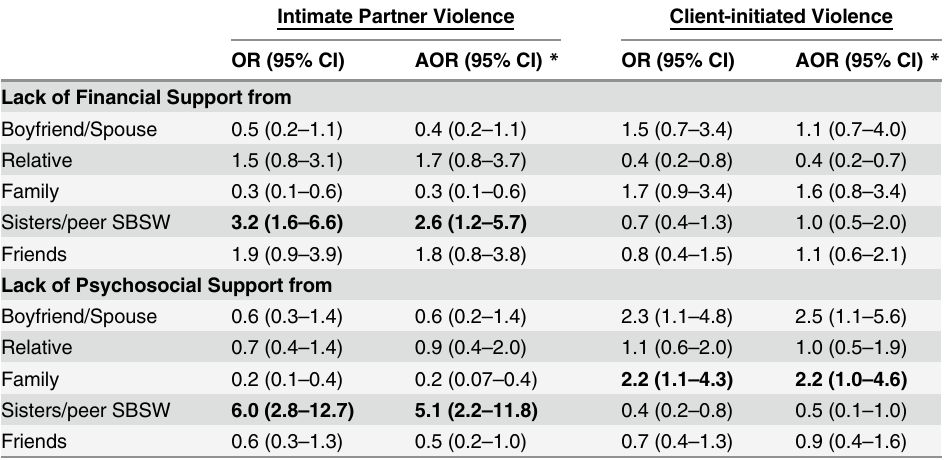
Table 4. Multi-variable regression of intimate-partner violence and client-initiated violence by sources of social support among female street-based sex workers in Shanghai, China, 2011 – 2012 (N = 218). Intimate Partner